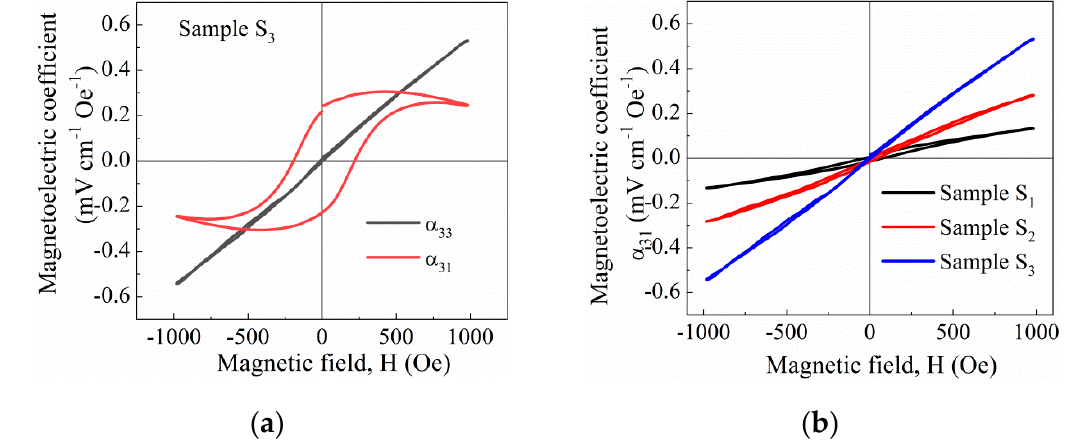
Figure 16. Room temperature magnetoelectric coefficients as a function of DC magnetic field of BNT–BT 0.08 /CoFe 2 O 4 core–shell ceramics: ( a ) for sample with 1:1.5 molar ratio (sample S 3 ) measured in both longitudinal ( α 33 ) and transverse ( α 31 ) modes after poling at 2 kV/mm, and ( b ) for ceramics with 1:0.5, 1:1 and 1:1.5 molar ratios (sample S 1 , sample S 2 and sample S 3 ).